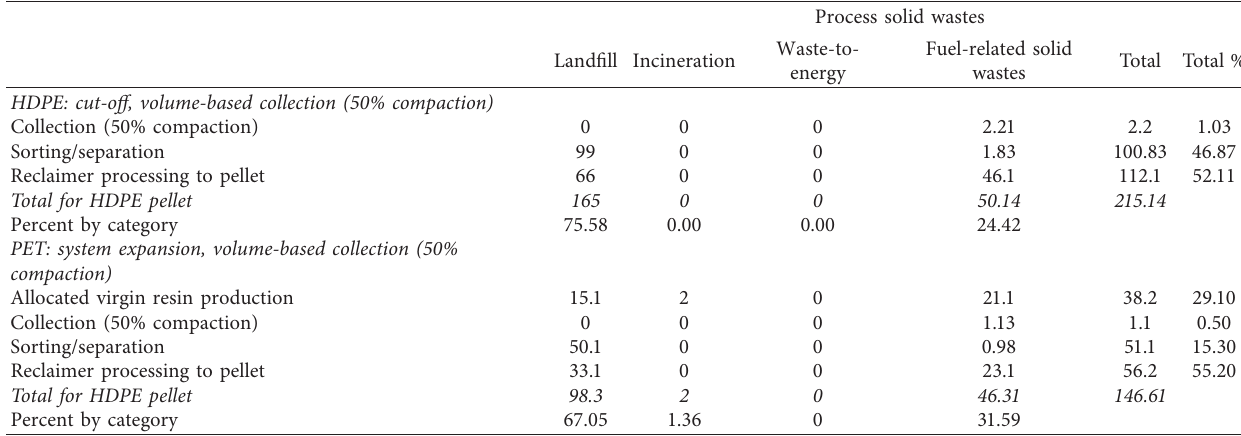
Table 12: Solid waste for recycled HDPE resin (kg of waste per ton of